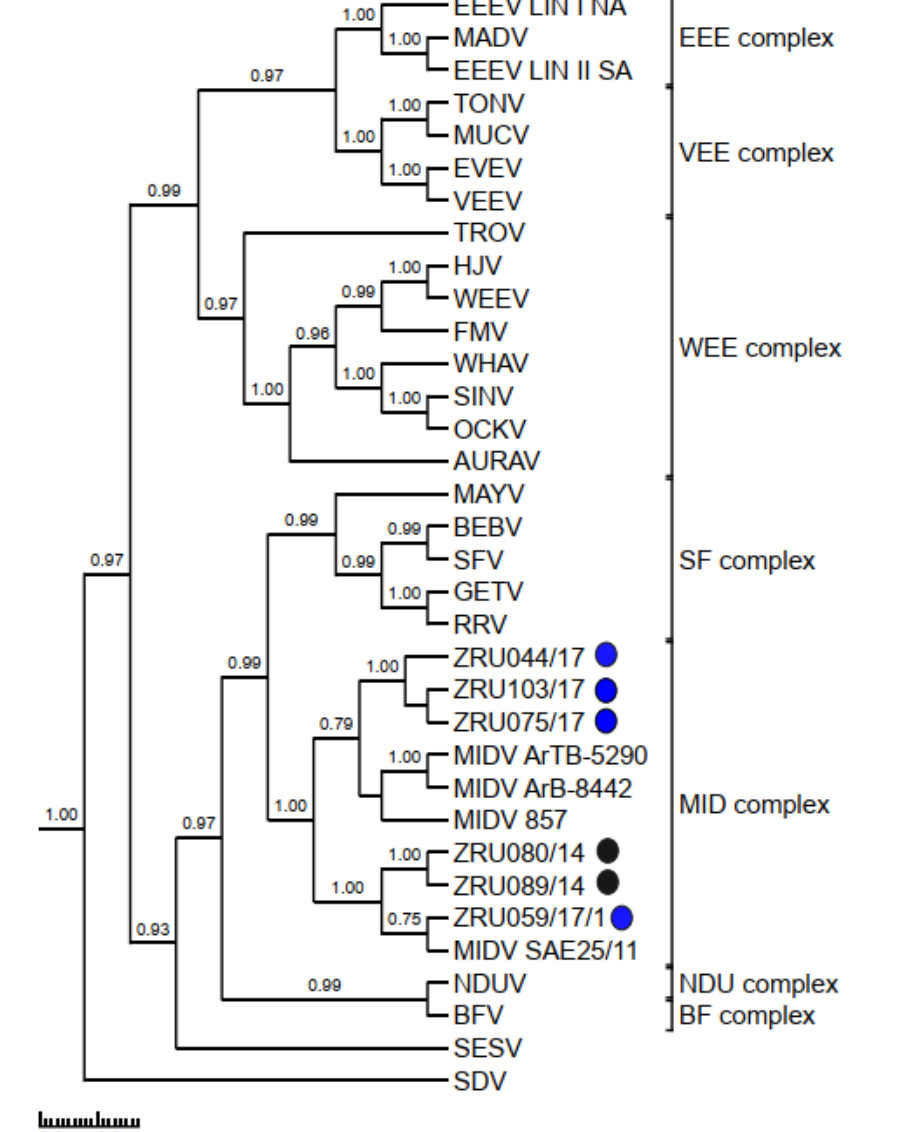
Figure 6. Rooted phylogenetic tree produced from Bayesian analysis using BEAST based on structural proteins (3777 base pairs) (35 taxa, model GTR+G+I) of alphaviruses is shown Posterior probabilities >0.7 are shown on major branches. Sequences of horse Middelburg virus positives described in the current study are indicated with ZRU numbers and circle colours correspond to year sample was screened as follows: 2014 indicated in black (sequences obtained from whole blood samples) and 2017 indicated in blue (sequences obtained from culture isolates). AURAV: Aura virus; BF: Barmah Forest virus; CHIKV: Chikungunya virus; EILV: Eilat virus; EEEV: Eastern equine encephalitis virus; EVEV: Everglades virus; GETV: Getah virus; MAYV: Mayaro virus; MIDV, Middelburg virus; MUCV: Mucambo virus; NDUV: Ndumu virus; OCKV: Ockelbo virus; PIXV: Pixuna virus; RRV: Ross river virus; SDV: Sleeping disease virus; SEV: Southern elephant seal virus; SFV, Semliki Forest virus; SINV: Sindbis virus; TALV: Taï Forest alphavirus; TONV: Tonate virus; TROV: Trocara virus; VEEV: Venezuelan equine encephalitis virus; WHAV: Whataroa virus; WEE: Western equine